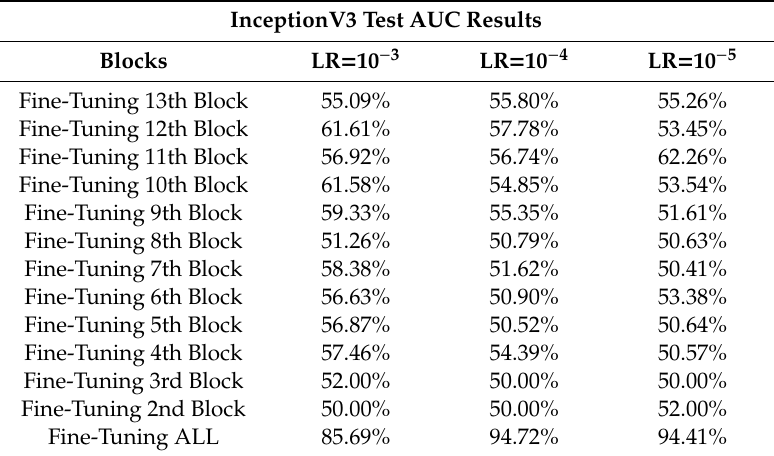
Table 8. Results of the InceptionV3 architecture using the BreakHis